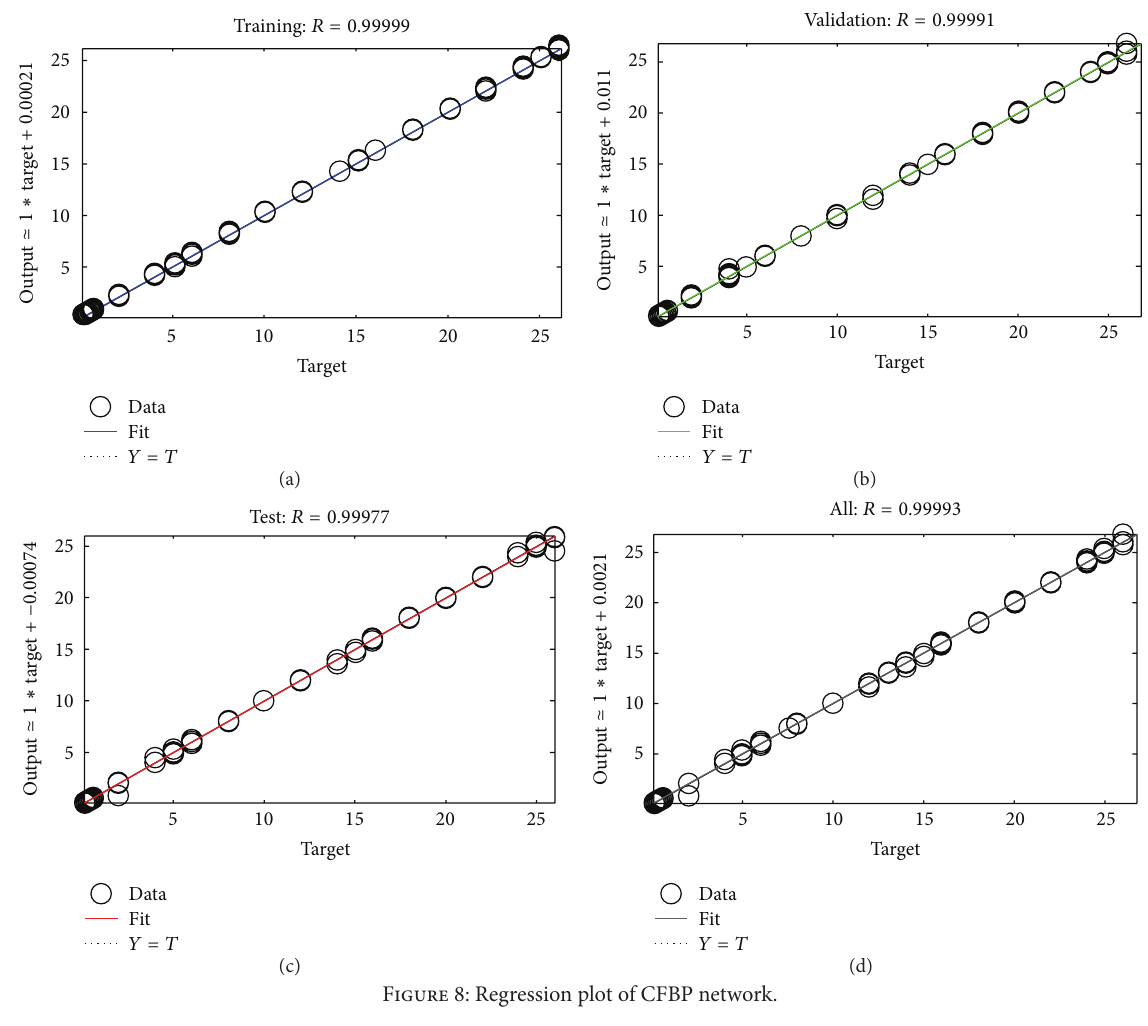
Figure 8: Regression plot of CFBP network.